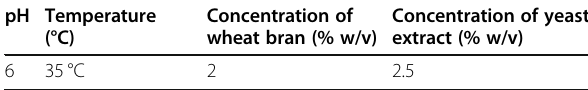
Table 3 Optimized settings for each